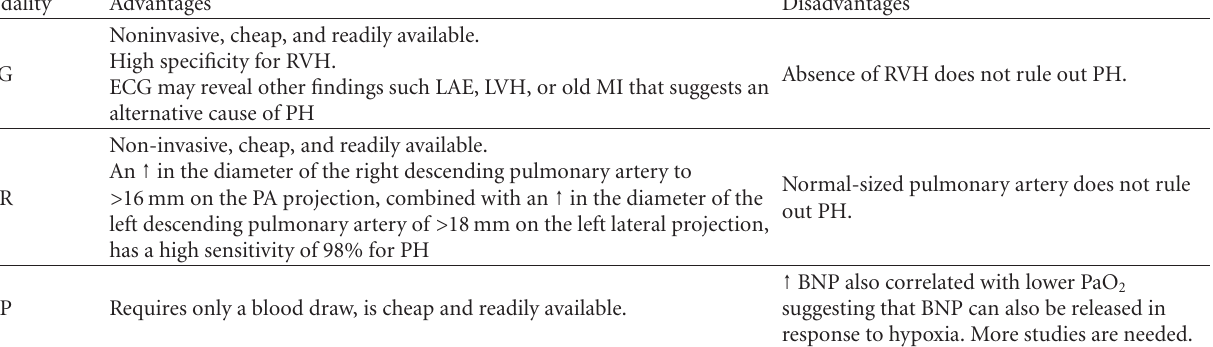
Table adapted from [63]. PH: pulmonary hypertension, FEV1: forced expiratory volume in the first second, DLCO: di ff using capacity for carbon monoxide, PaO 2 : arterial oxygen